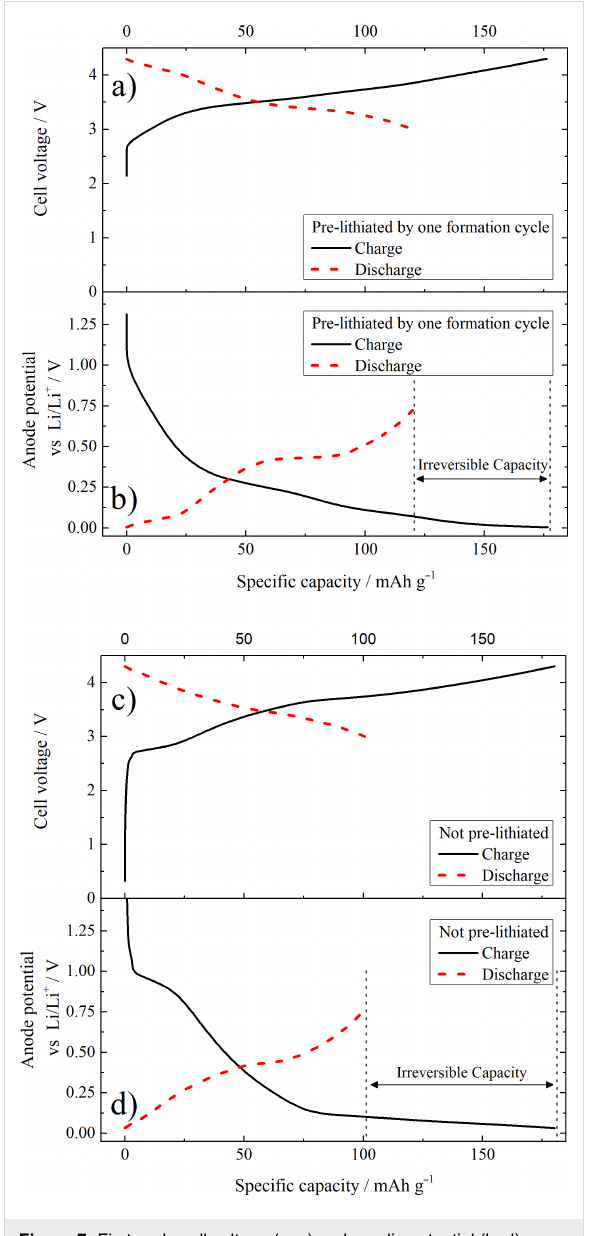
Figure 7: First cycle cell voltage (a, c) and anodic potential (b, d) profile using a full cell set-up with a prelithiated (a, b) and a non- prelithiated (c, d) C:Si 90:10 composite negative electrode (anode) vs a NMC-111 positive electrode (cathode). RE: metallic lithium, cut-off voltages: 3.0 V and 4.3